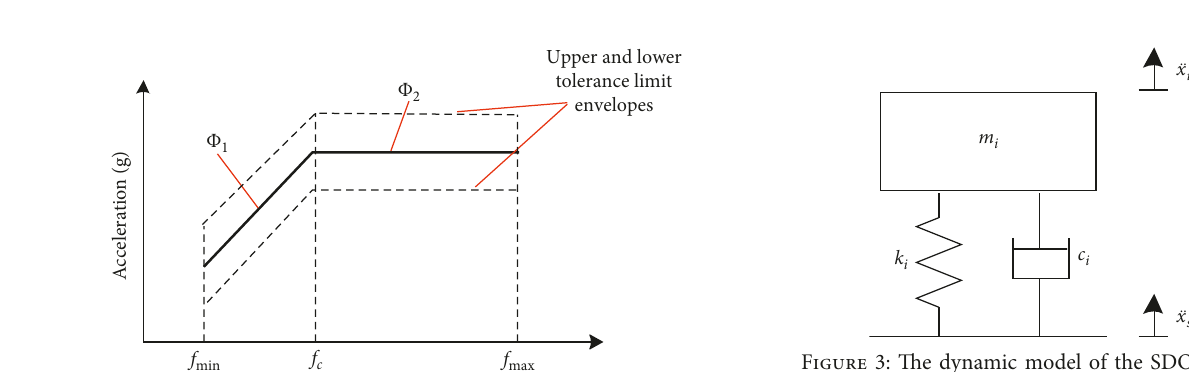
Figure 1: Principle of SRS.